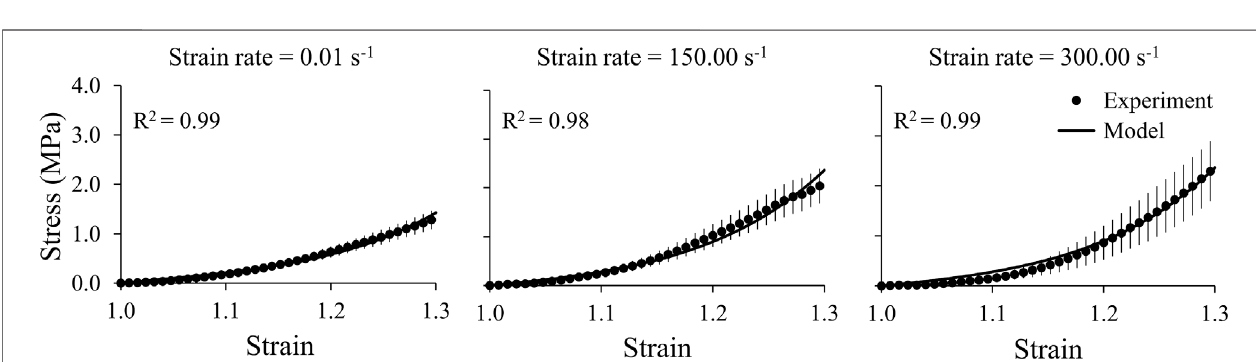
FIGURE 5 | A one-term Ogden hyperelastic, one-term Prony series model (solid lines) fi t to the average experimental stress-strain behavior (circles) for the middle cerebralarterysamplesatthreestrainrates(0.01,150.00,and300.00s -1 ).Thecirclesand verticallines represent themean( n (cid:1) 12)and onestandarderrorofthemean,